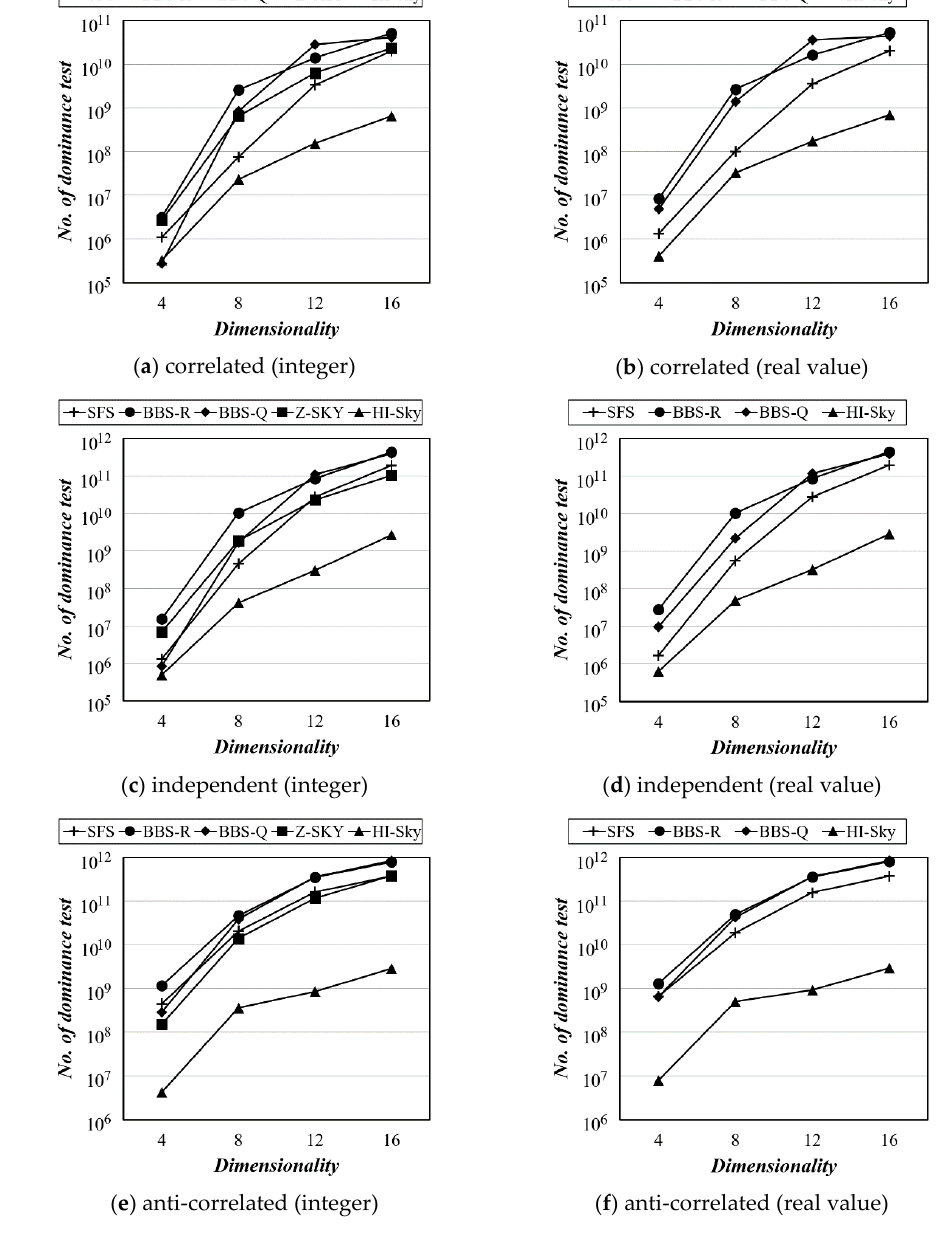
Figure 10. The number of dominance tests according to dimensionality (1 Million).